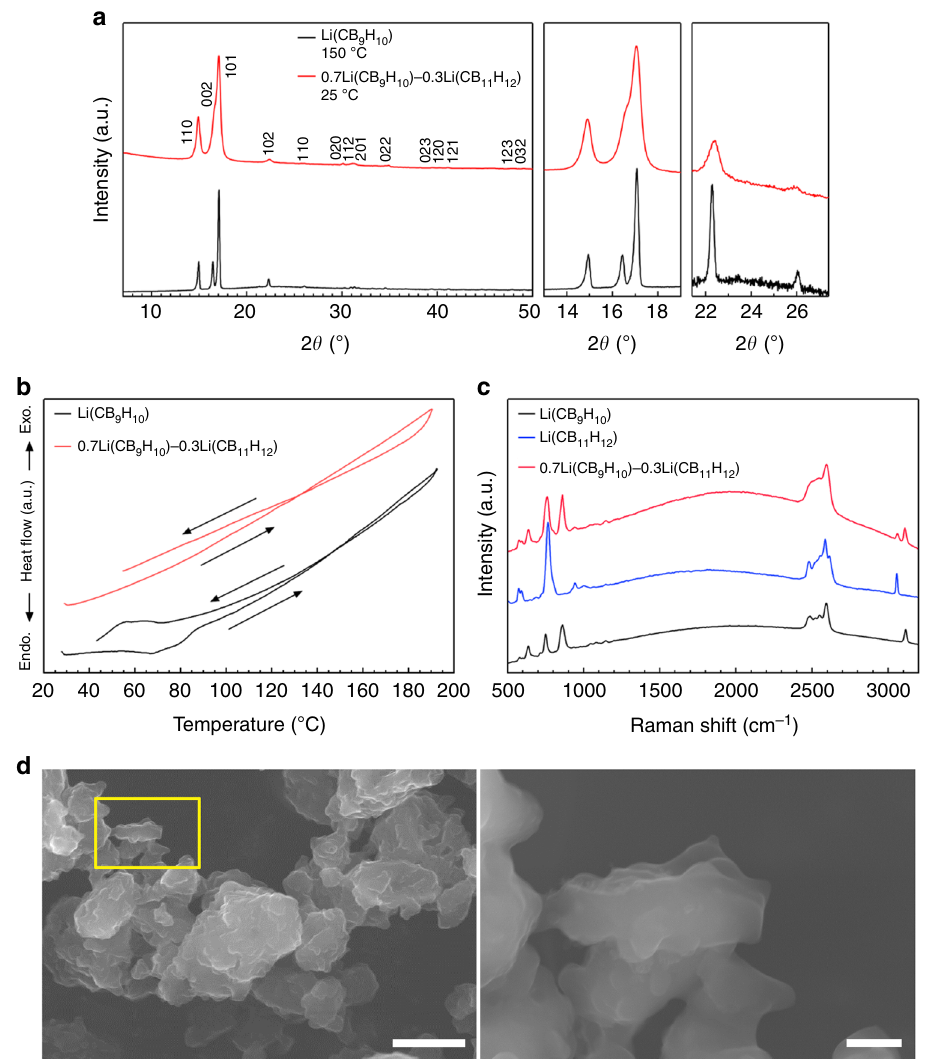
Fig. 1 Stabilization of high- T phase at room temperature. a XRD patterns of Li(CB 9 H 10 ) at 150 °C and 0.7Li(CB 9 H 10 ) – 0.3Li(CB 11 H 12 ) at room temperature. b DTA curves of Li (CB 9 H 10 ) and 0.7Li(CB 9 H 10 ) – 0.3Li(CB 11 H 12 ). c Raman spectra of Li(CB 9 H 10 ), Li(CB 11 H 12 ), and 0.7Li(CB 9 H 10 ) – 0.3Li(CB 11 H 12 ). d FE-SEM images of 0.7Li(CB 9 H 10 ) – 0.3Li(CB 11 H 12 ). The magni fi ed image (right) is of the yellow marked area (left). Scale bars, 20 μ m for the left image in d and 3 μ m for the right image in